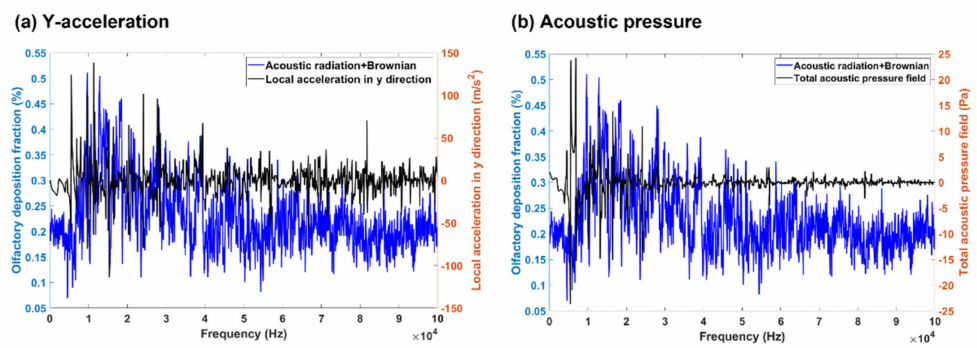
Figure 10. A general correlation between ( a ) acceleration in the y-direction, ( b ) acoustic pressure, and the olfactory